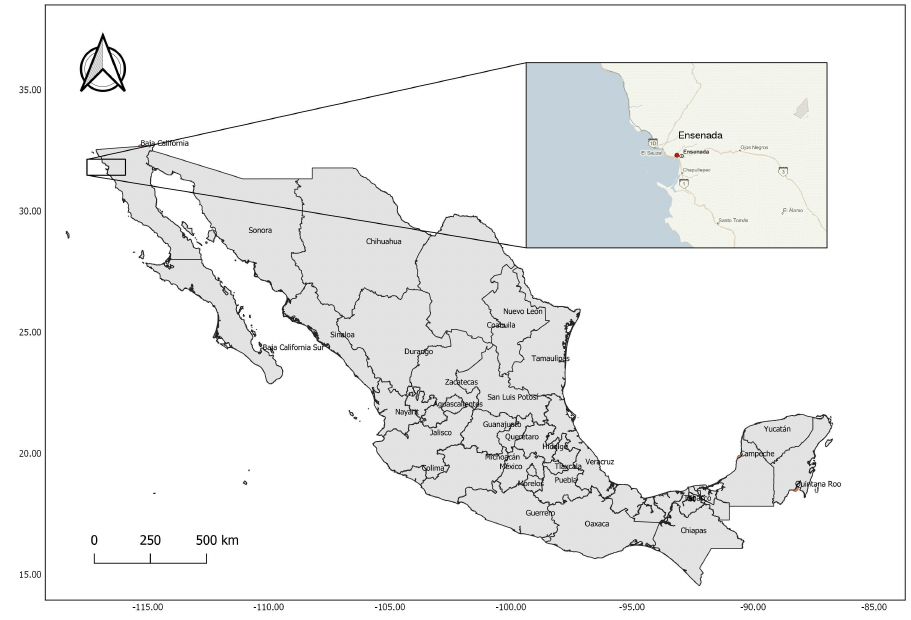
Figure 1. Location map of the study